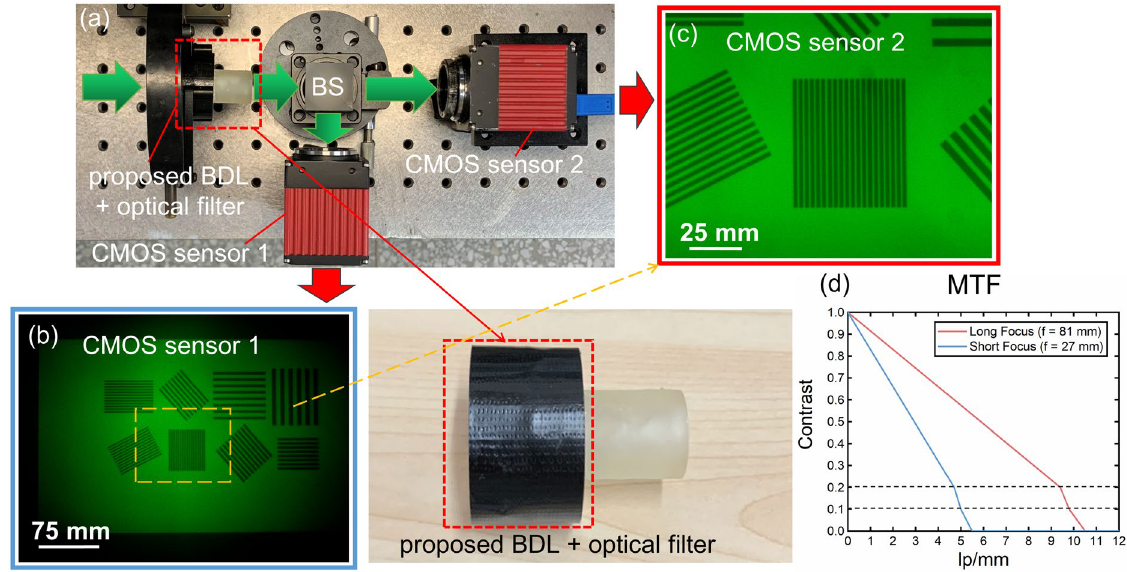
Figure. 8. A dual-sensor imaging system employing the BDL. ( a ) Setup of the imaging system. ( b ) Wide FOV image taken by CMOS sensor 1. ( c ) High-resolution magnified image taken by CMOS sensor 2. ( d ) The MTF of the long and short focal spots of the